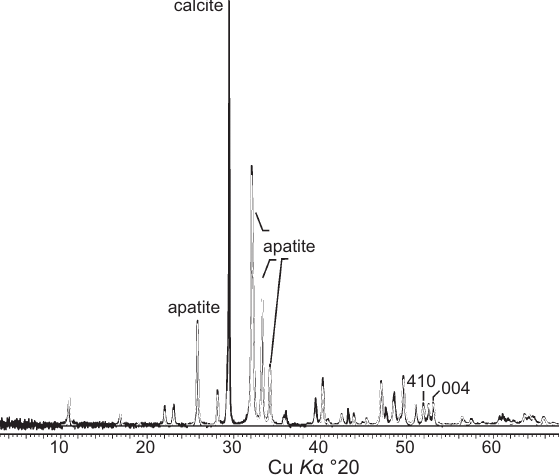
Fig. 4. Representative X-ray diffraction pattern of Sphenothallus aff. lon- gissimus , Viivikonna Formation, lowermost Sandbian, Kohtla, NE Esto- nia. Dark gray line indicates modelled apatite pattern fitted to measured pattern. Position of reflections 410 and 004 were used to estimate carbon- ate ion content in carbonate-fluor apatite structure.